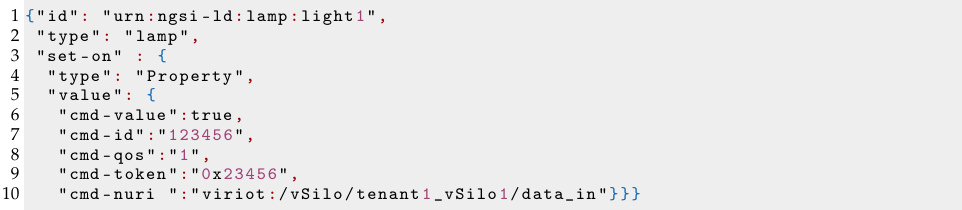
Figure 8. Virtual Actuator workflow; QoS = 2. Table 8. set-on